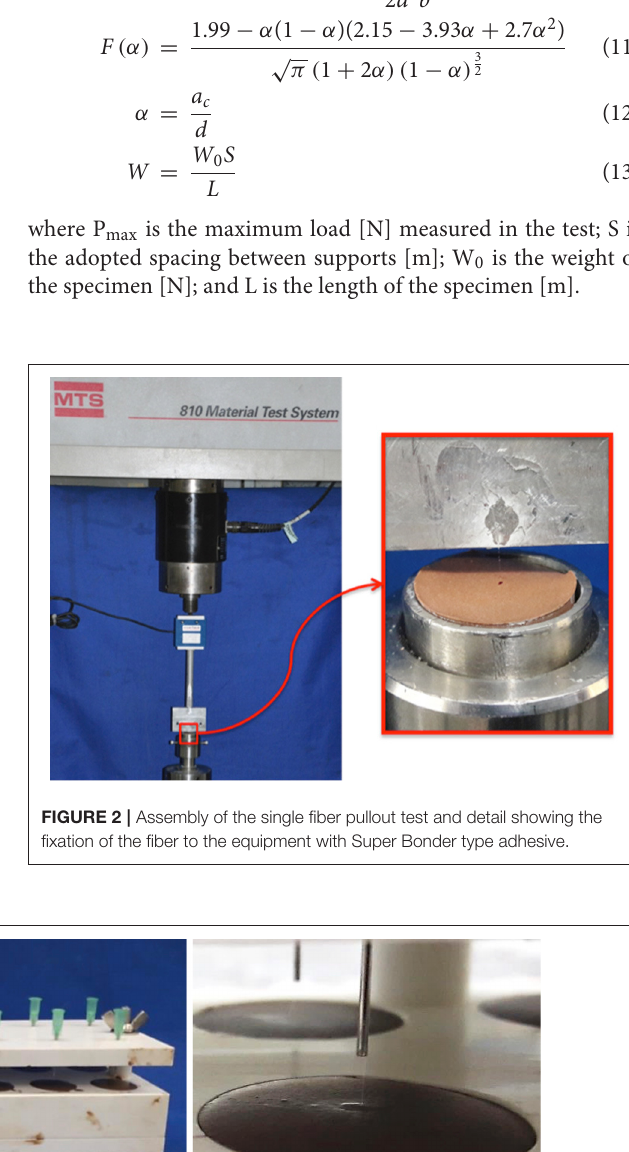
Frontiers in Materials |